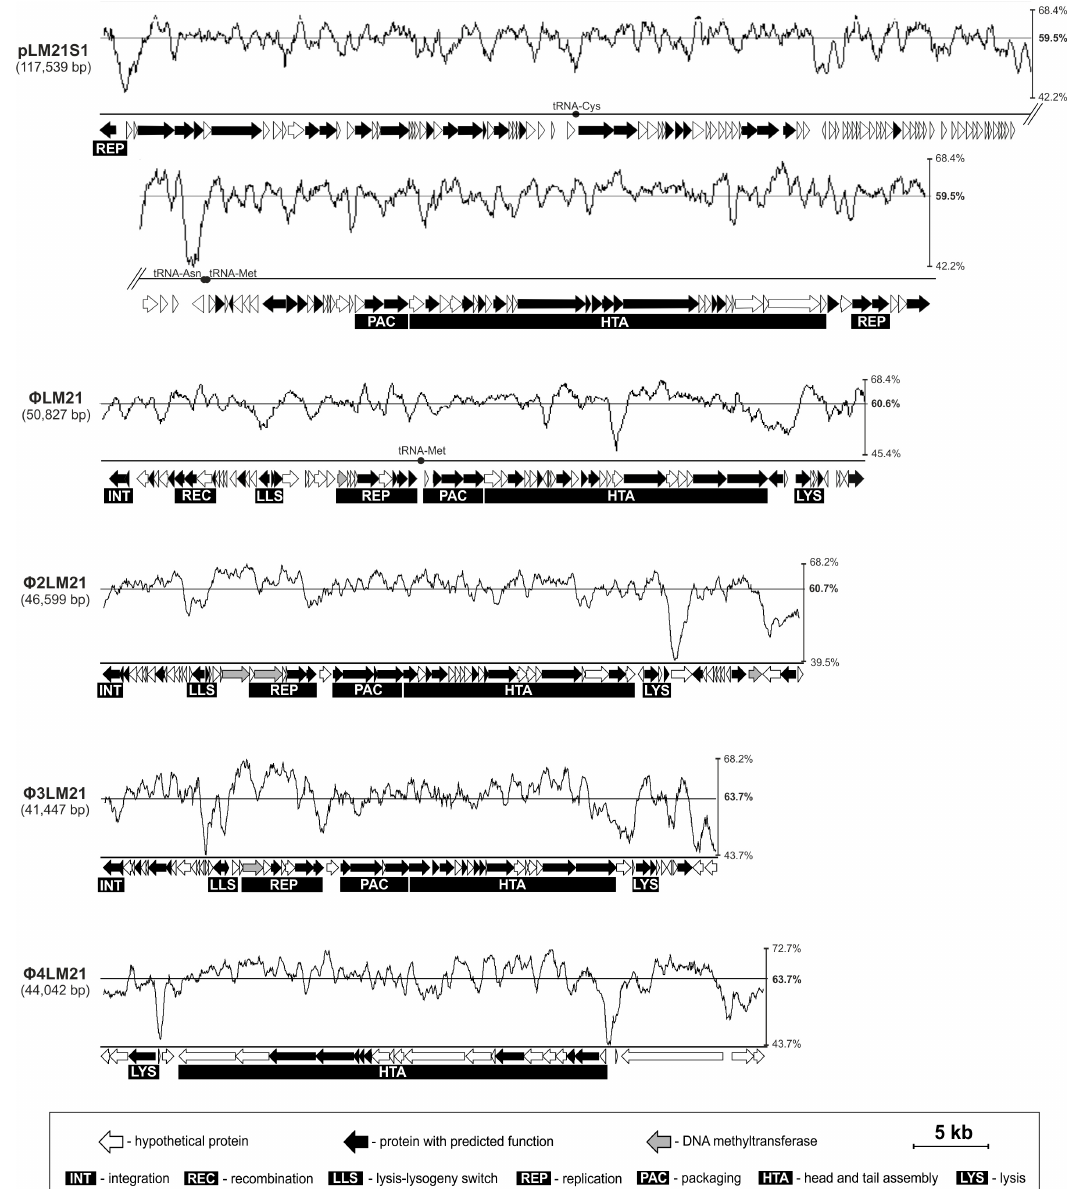
Figure 1. Genome organization of pLM21S1, Φ LM21, Φ 2LM21 and Φ 3LM21 prophages, and Φ 4LM21 prophage remnant of Sinorhizobium sp. LM21. Arrows indicate the transcriptional orientation of the genes. The plots show the GC contents of the prophages. The genetic map of pLM21S1 was divided to retain transparency. The virus-specific genetic modules were indicated by the black boxes.